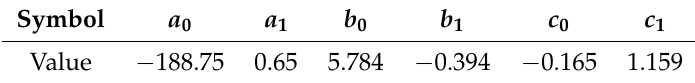
Table 2. List of empirical coefficients describing the Capstone C65 MGT black box